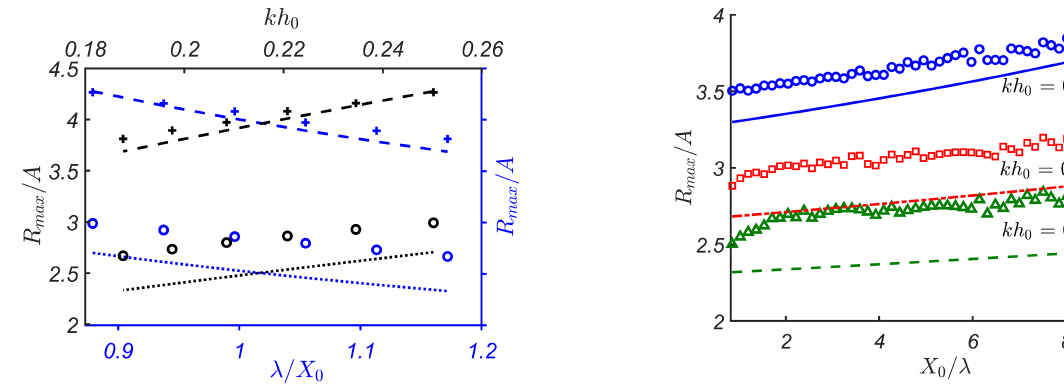
Figure 8. Maximum run-up height, R max /A , as a function of the distance to the slope, X 0 /λ , for different values of kh 0 . Analytical solution described in Sect. 2 is shown by lines, and numerical so- lution described in Sect. 3 is shown by symbols (triangles, squares and circles) with matching colours ( A/h 0 = 0 . 03).